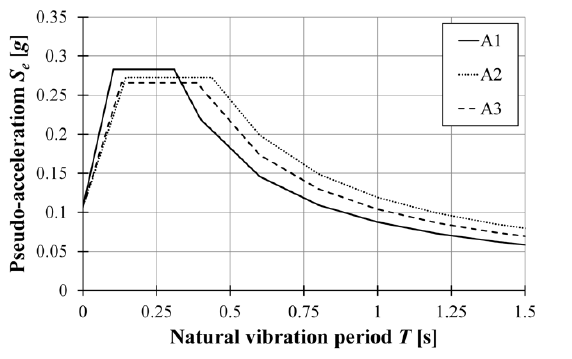
Figure 7. Elastic response spectra S e (T) . Table 1. Parameters considered in the parametric study.